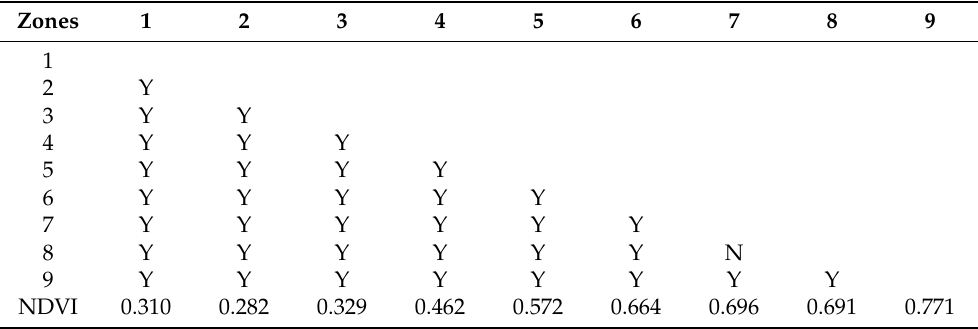
Table 9. Mean value of the NDVI and significant differences in annual precipitation between two regions.